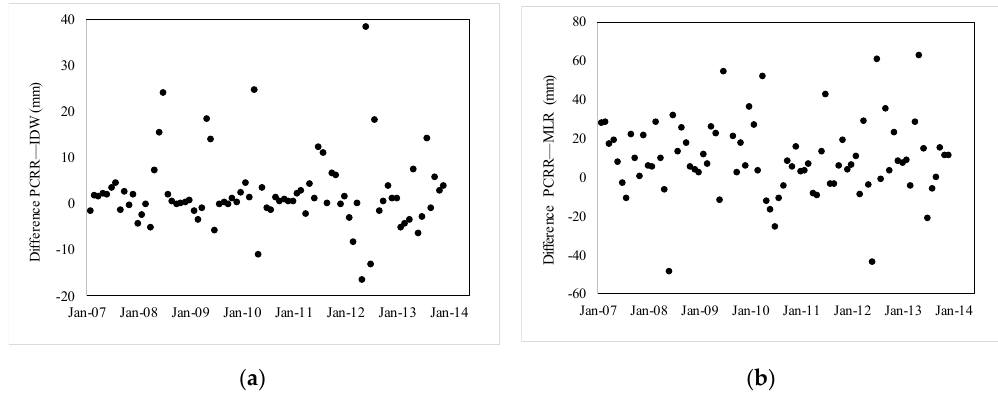
Figure 5. Differences in monthly rainfall for the Xinxie catchment using different interpolations: ( a ) PCRR-IDW and ( b ) PCRR-MLR.